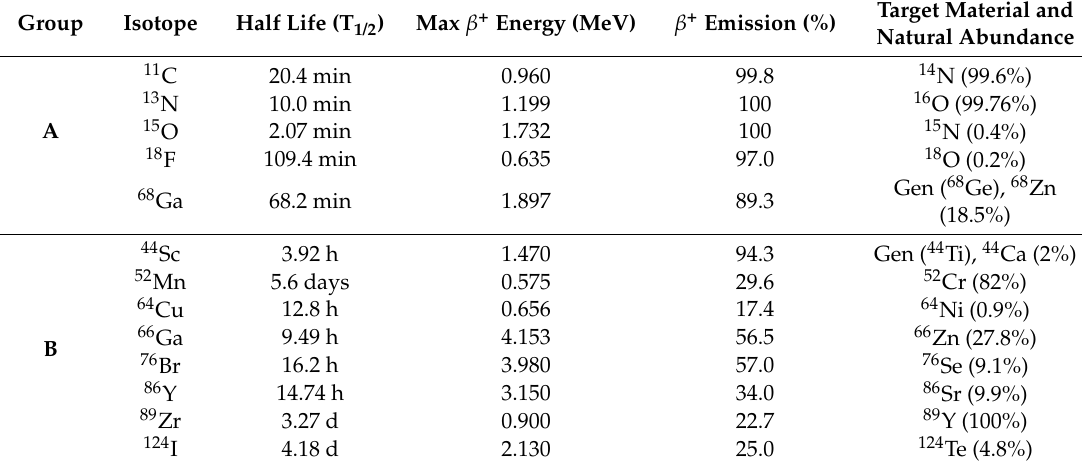
Table 3. Common positron emitting